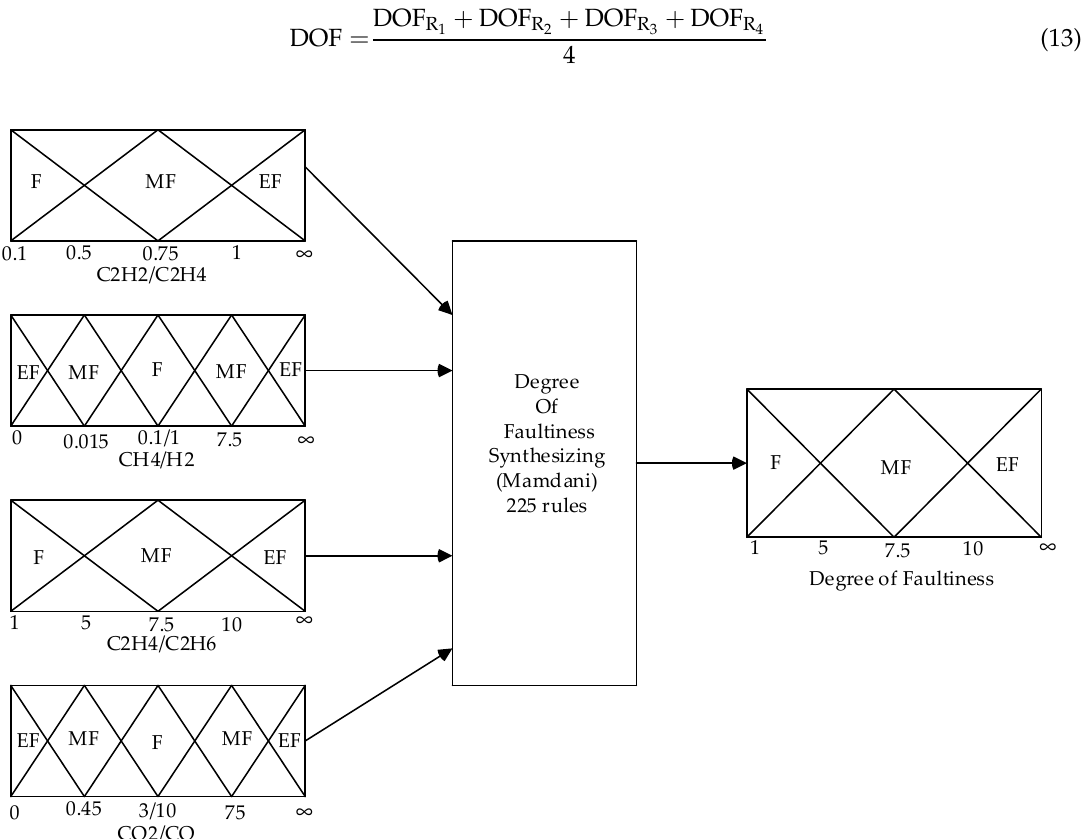
Figure 3. Schematic diagram on how to synthesize degree of faultiness (DOF) based on fuzzy logic .